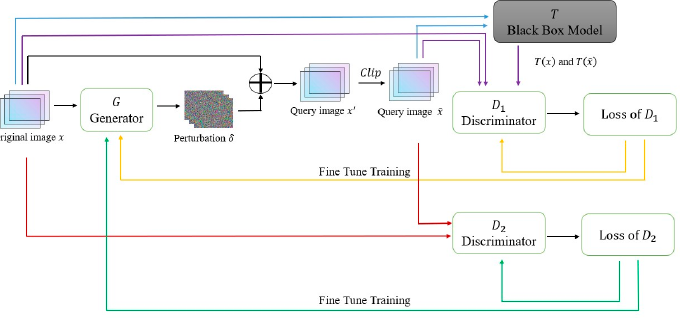
Figure 1. The proposed DDSG-GAN model.